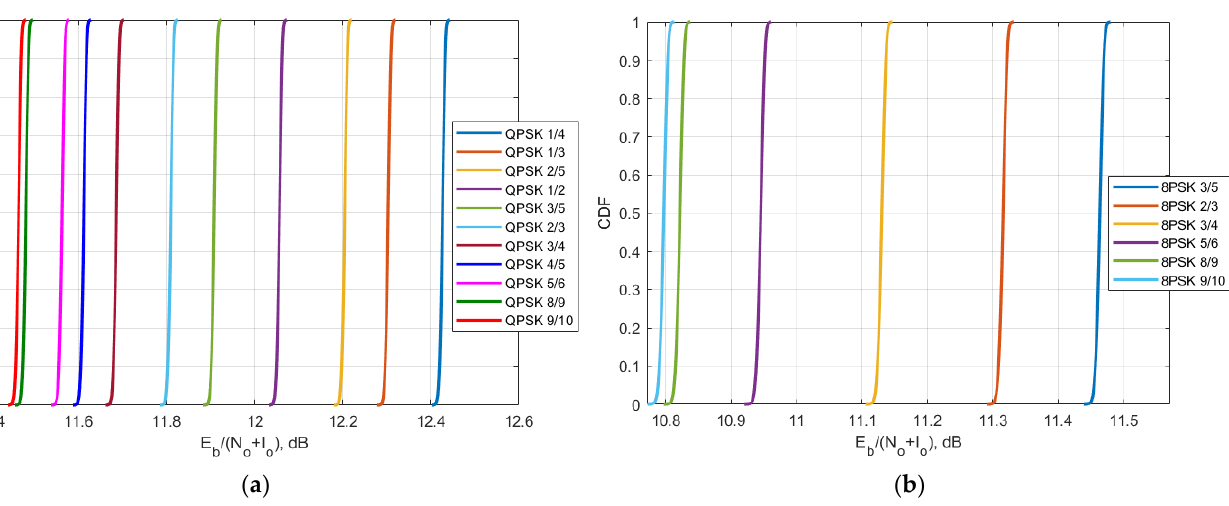
( b ) Figure 16. The CDF of E b /N o +I o of Express 140E: ( a ) for QPSK modulation; ( b ) 8PSK modulation.